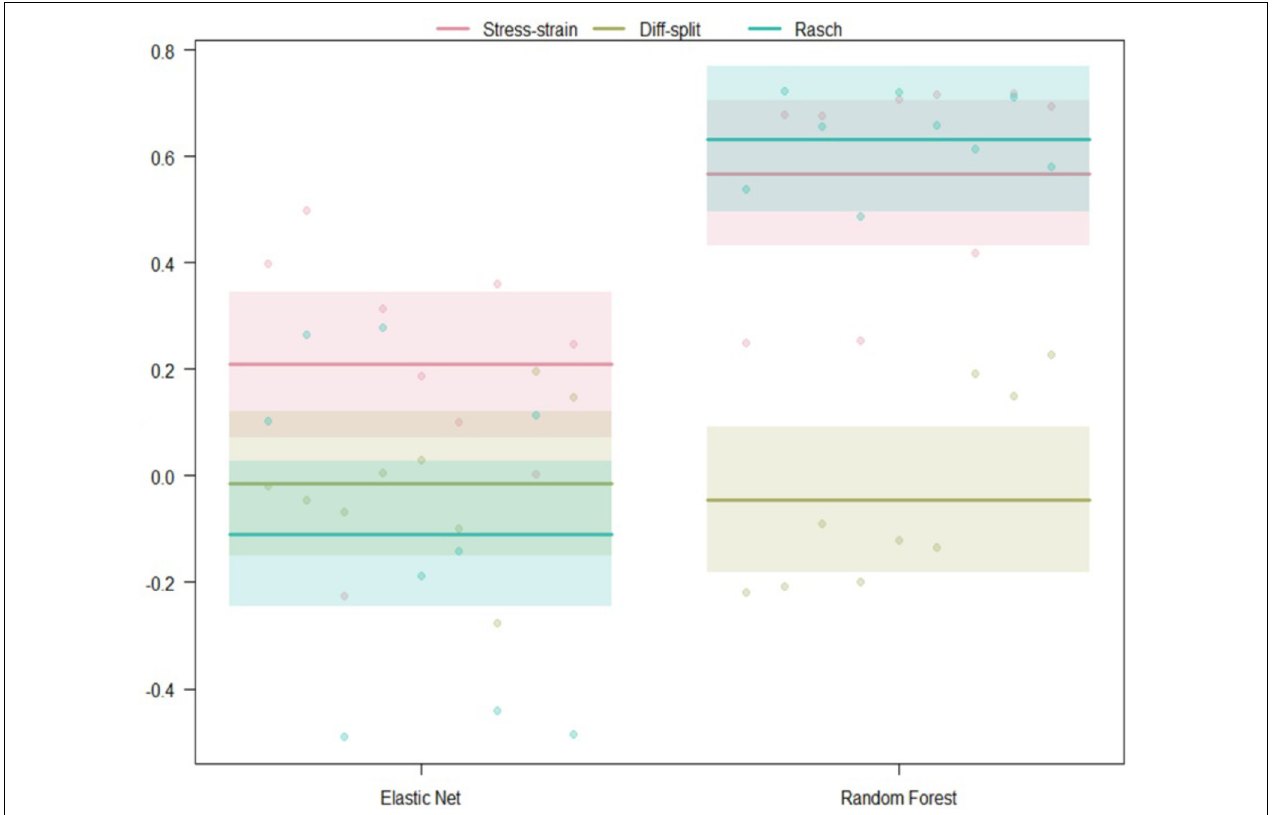
FIGURE 8 | Regression estimates for hold-out participants on the WM task across labeling technique and machine learning algorithm. Points along the y -axis are GINI Index values for individual folds, lines are the regression estimate, and bars are the error of the